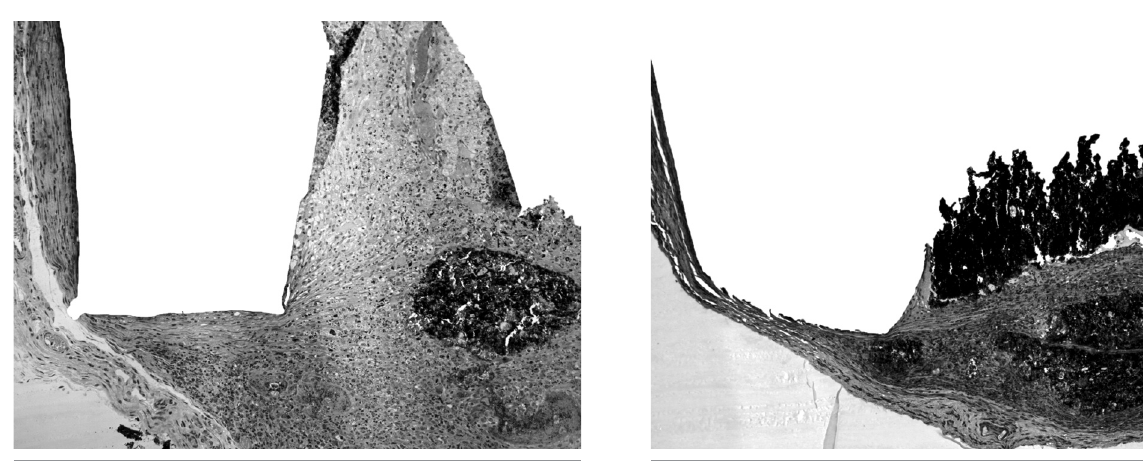
Figure 3. Inflammatory response in non-diabetic Sealapex group at day 30: moderate inflammatory cell infiltration (hematoxylin-eosin, 10X).